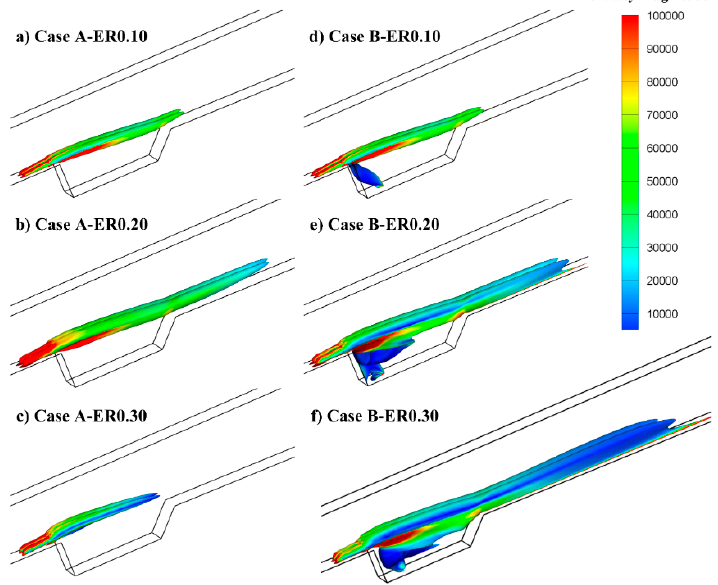
Figure 15. Iso-surface of the ethylene mass fraction (of 0.10) colored by vorticity magnitude of injection schemes A and B cases.